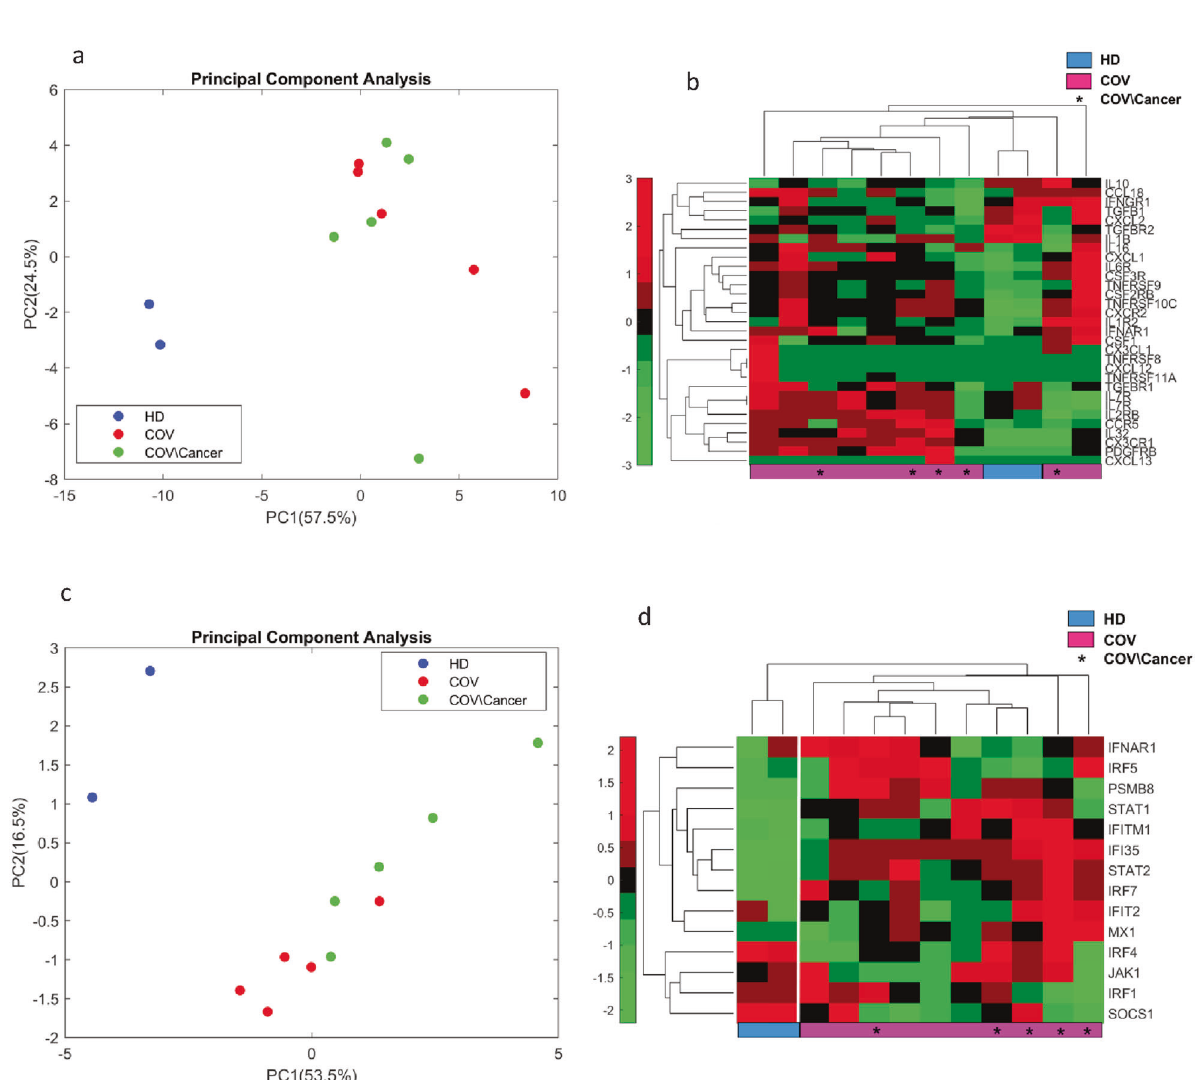
Fig. 4 Evaluation of cytokines & chemokines and type I IFN-related genes signature on NanoString gene expression pro fi le. a , b Principal component analysis and hierarchical clustering of a cytokines & chemokines gene signature reported in Hadjadj J. et al., 2020. The signature is able to discriminate HD ( n = 2) from COV patients ( n = 5). Cancer patients are also indicated ( n = 5). c , d Principal component analysis and hierarchical clustering of a type I IFN gene signature reported in Hadjadj et al., 2020. The signature is able to discriminate HD ( n = 2) from COV patients ( n = 5). A difference is also evident between COV/cancer ( n = 5) and COV patients ( n = 5). 2020 is also able to discriminate COVID-19 subjects versus HD in our cohort (Fig. 3b). Of note, in the last analysis, our gene signature is clearly able to cluster COVID-19 patients on the basis of clinical severity, too. Next, we aimed to identify genes whose expression was selectively modulated between COVID-19 patients with cancer or without cancer. Gene Set Enrichment Analysis (GSEA) carried